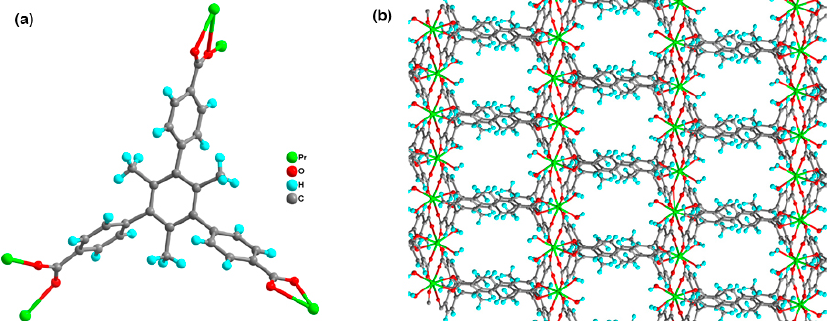
Figure 1. ( a ) View of the coordination environment around the H 3 TMTA ligand and ( b ) three-dimensional porous framework of 1 viewed along the b axis.